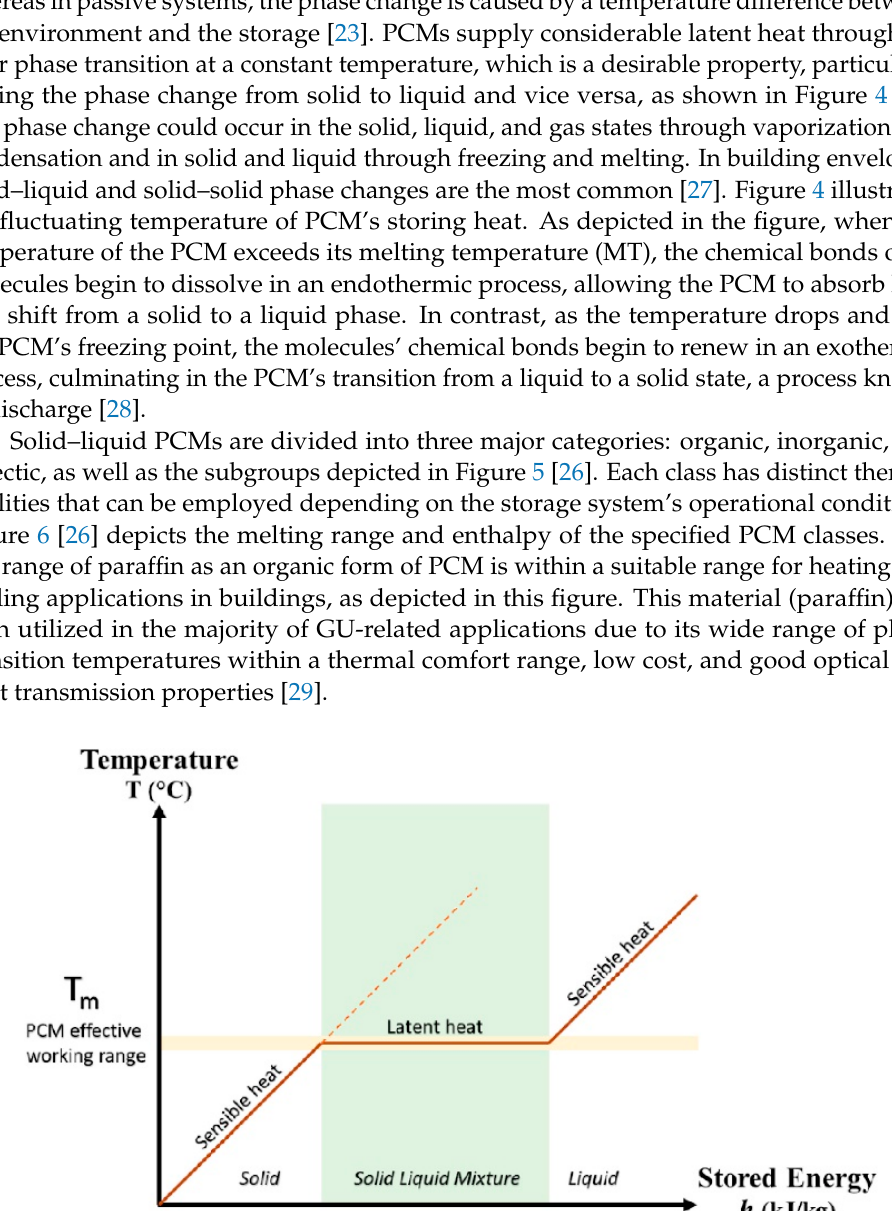
Table 2. Comparing the sensible and latent heat of TES materials for 15 K temperature increase and 300 kWh energy storage [25].